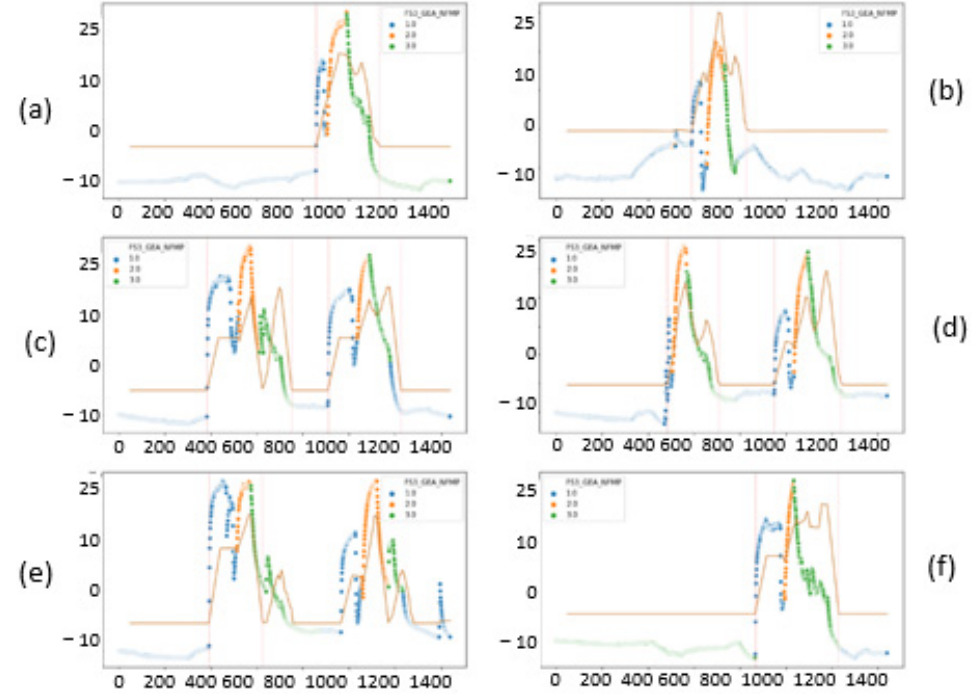
Figure 6. Example of 6 days of batch drying (from left to right and top to bottom): ( a ) 26 January 2018, ( b ) 30 August 2018, ( c ) 7 February 2019, ( d ) 7 February 2019, ( e ) 6 April, and ( f ) 25 January 2018.